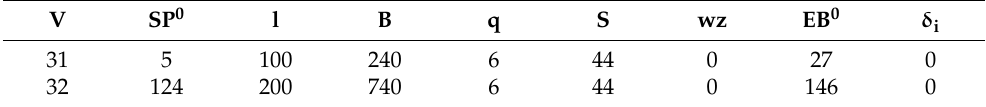
Table 2. Information of unscheduled